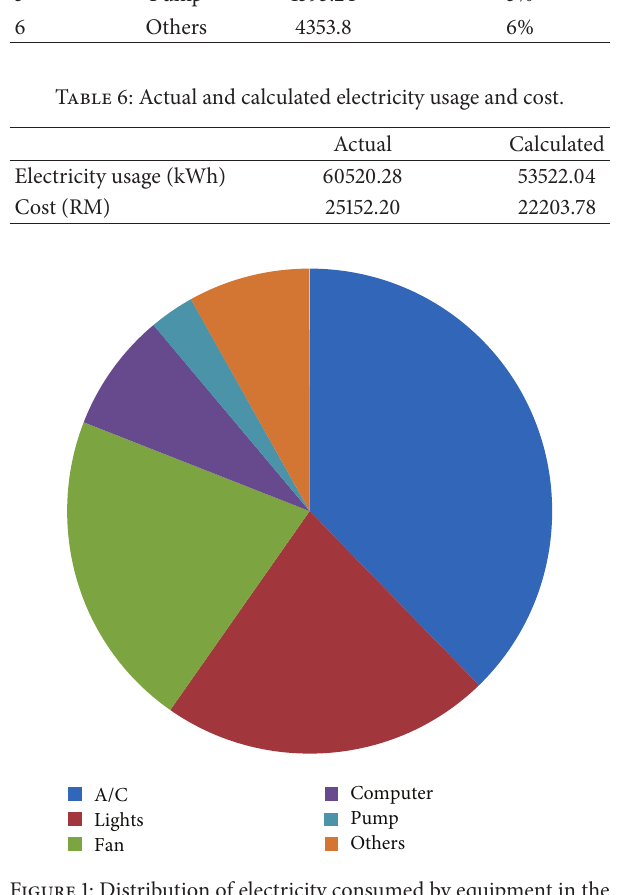
Figure 1: Distribution of electricity consumed by equipment in the